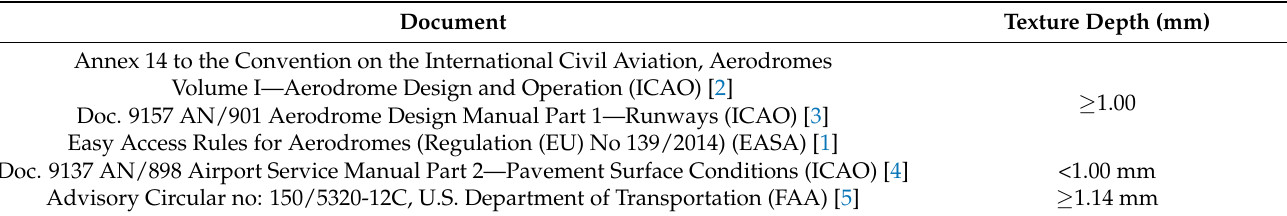
Table 4. Texture depth requirements for new airport